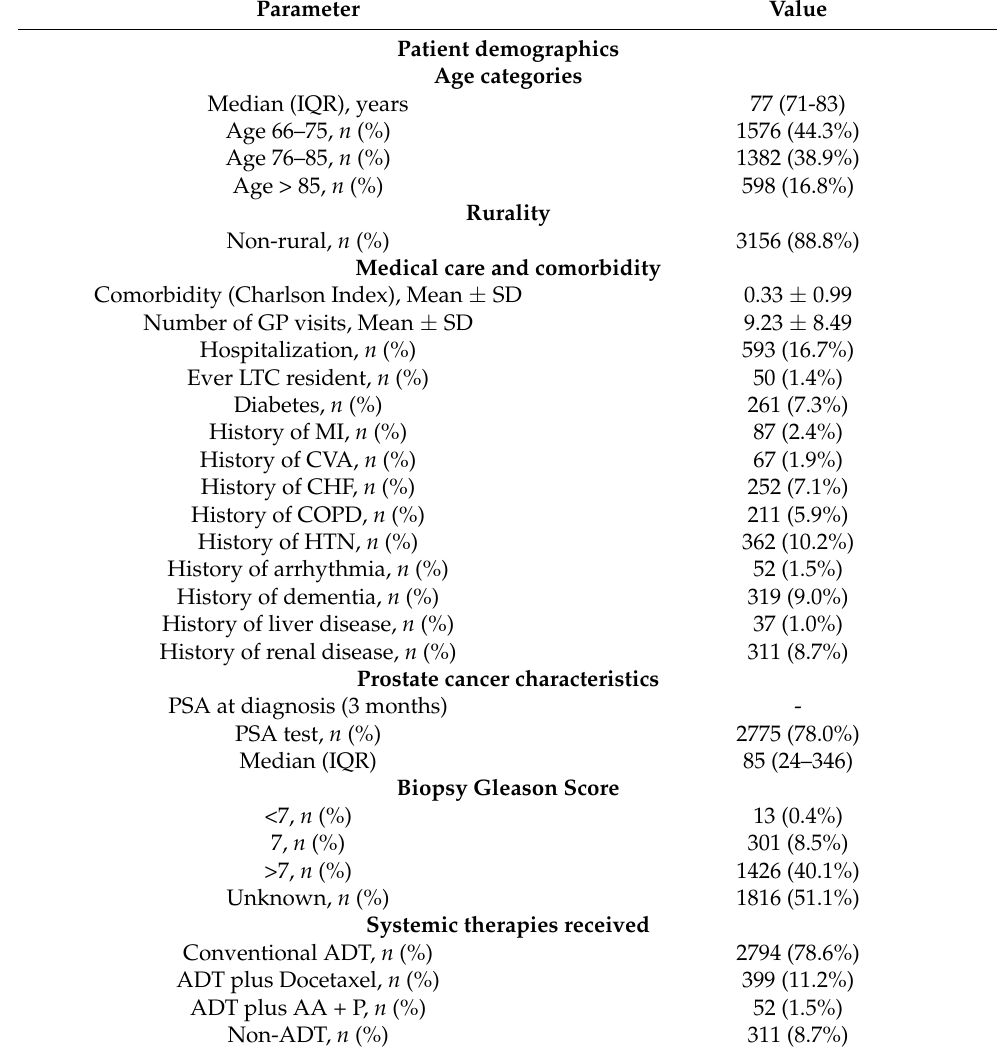
Table 1. Baseline